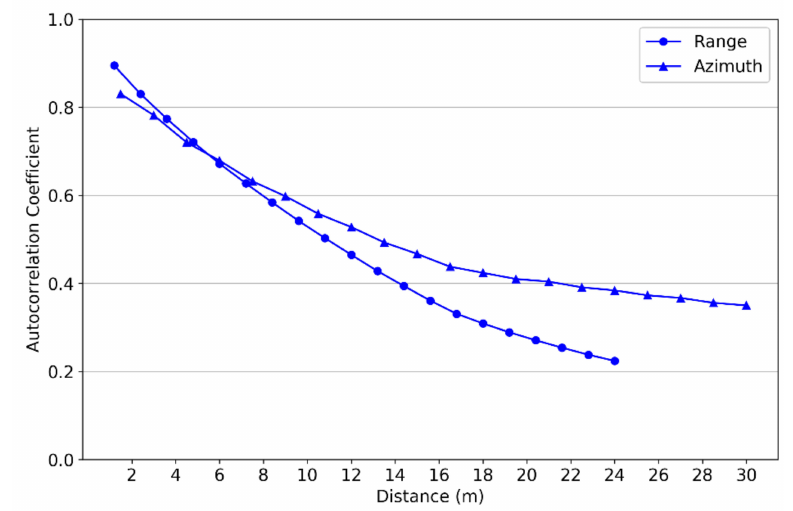
Figure 7. Spatial autocorrelation of the elevation